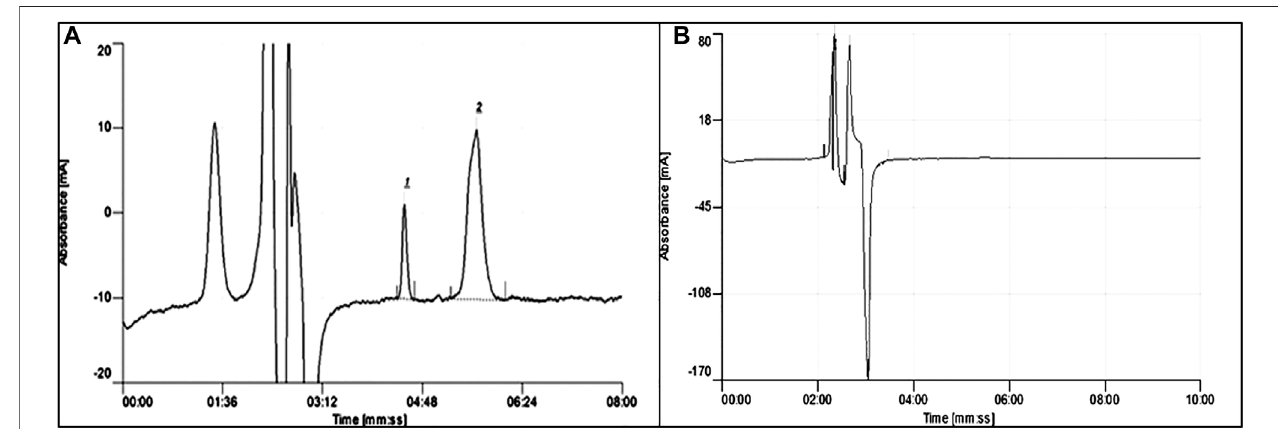
FIGURE 1 | Chromatogram of 1: OXB (10 μ g/ml) and 2: MP (0.25 μ g/ml) (A) and permeation medium (B) .